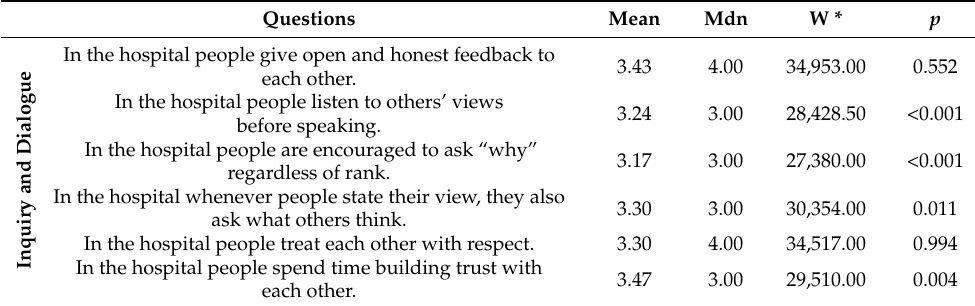
Table 5. Comparison of the individual characteristics of the “Inquiry and Dialogue” dimension to the neutral value with the use of the one-sample Wilcoxon sign rank